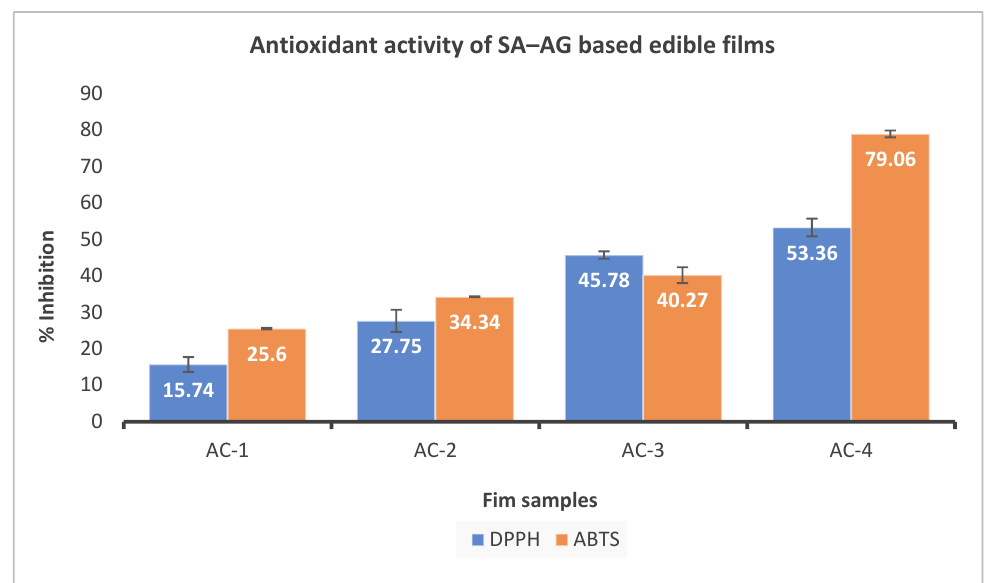
Figure 6. Antioxidant activity of SA–AG-based composite edible films; AC-1/Control, AC-2 contains 15 μL of CEO, AC-3 contains 20 μL of CEO, and AC-4 contains 30 μL of CEO.